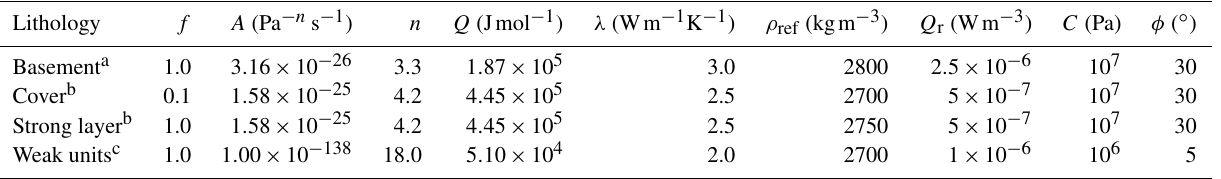
Table 1. The list of the reference model parameters, where f is a custom pre-factor, A is the pre-exponential factor, n is the power-law exponent, Q is the activation energy, λ is the thermal conductivity, ρ ref is the density at reference pressure ( P ref = 0Pa) and temperature ( T ref = 0 ◦ C), Q r is the radioactive heat production, C is the cohesion, and φ is the friction angle. Some parameters have constant values: C p = 1050JK − 1 is the heat capacity, G = 10 10 Pa is the shear modulus, α = 3 × 10 5 K − 1 is the thermal expansion coefficient, β = 10 − 11 Pa − 1 is the compressibility, and F = 2 ( 1 − n)/n 3 − (n + 1 )/( 2 n) is a geometry factor (needed to convert flow law parameters from axial compression experiments into an invariant form).